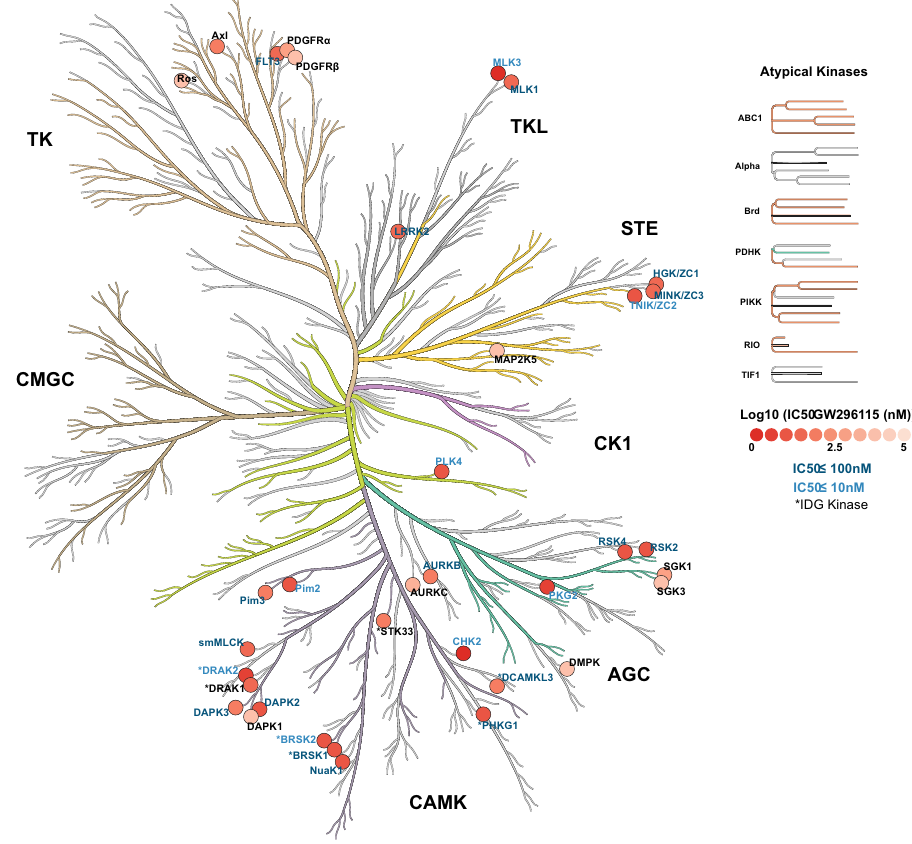
Figure 6. Enzymatic assay profile of GW296115. CORAL kinome tree representing kinases inhibited by GW296115 labeled according to IC 50 , and IDG status (*). Coral was used to make this kinome tree: https :// phans tiel-lab.med.unc.edu/CORAL